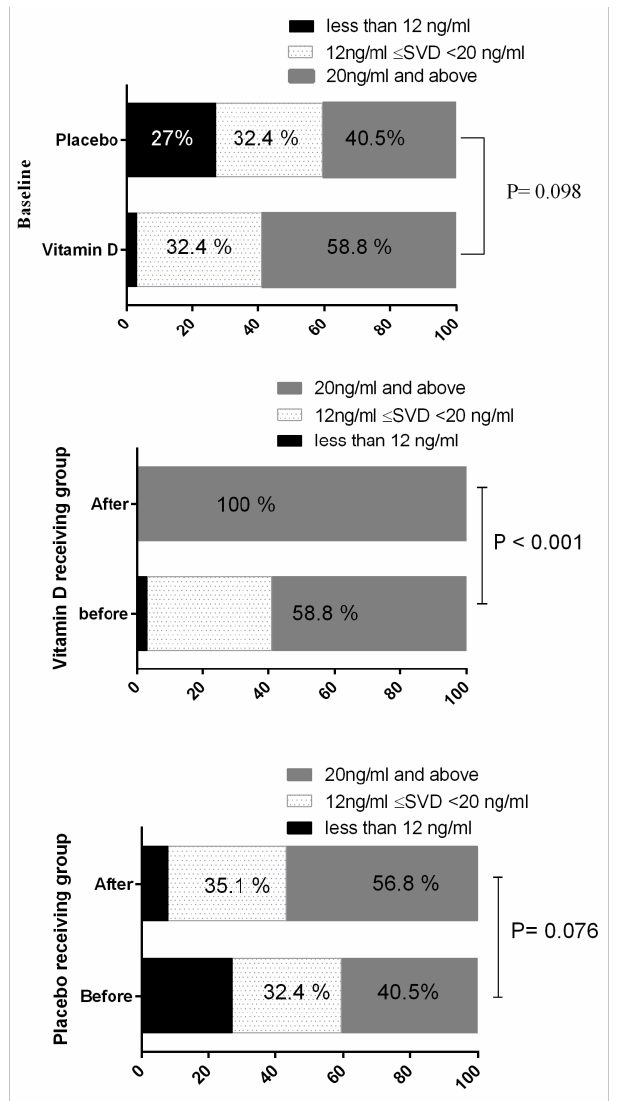
Figure 2. Vitamin D status in the study groups at the baseline and during the study period. Statistical analysis was done by Chi-Square and sign test. Data are presented is percentages. SVD: Serum Vitamin D.